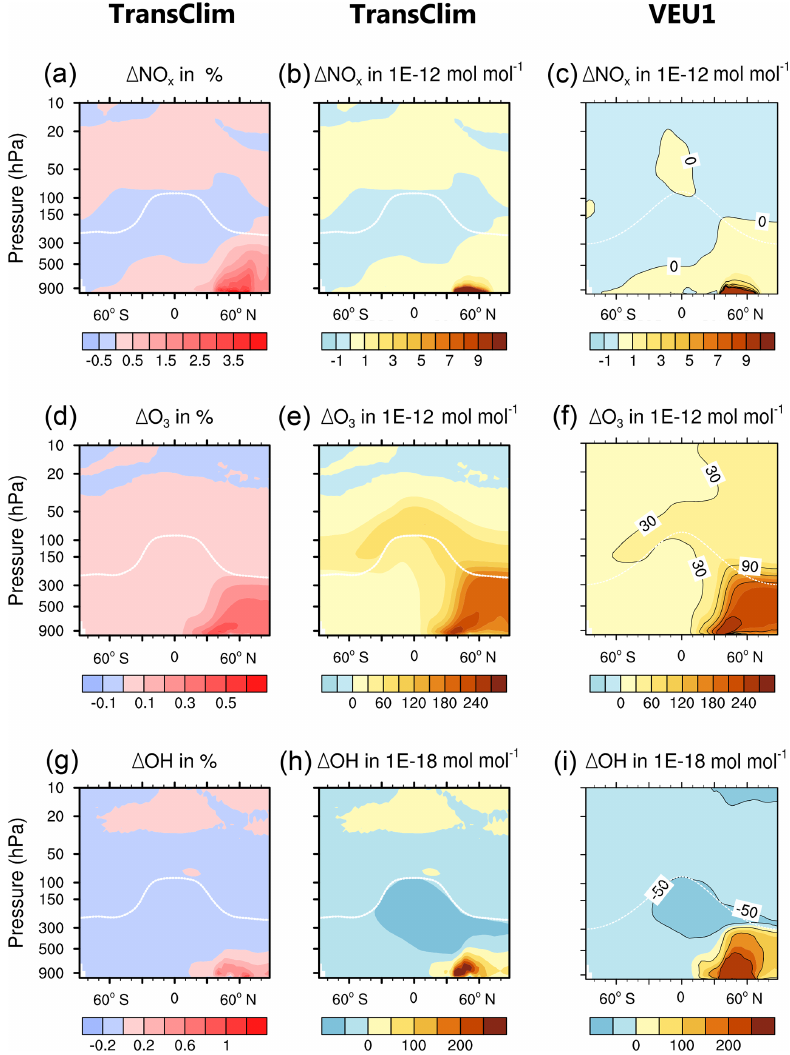
Figure 8. Zonal mean of relative and absolute NO x , O 3 and OH change caused by European road traffic emissions for the year 2030. Simulations performed with TransClim and EMAC (conducted within VEU1) are compared. The first and second column show the relative and absolute changes simulated with TransClim. The third column shows the absolute changes simulated with EMAC (taken from Fig. 6 in Hendricks et al., 2018). The white line indicates the